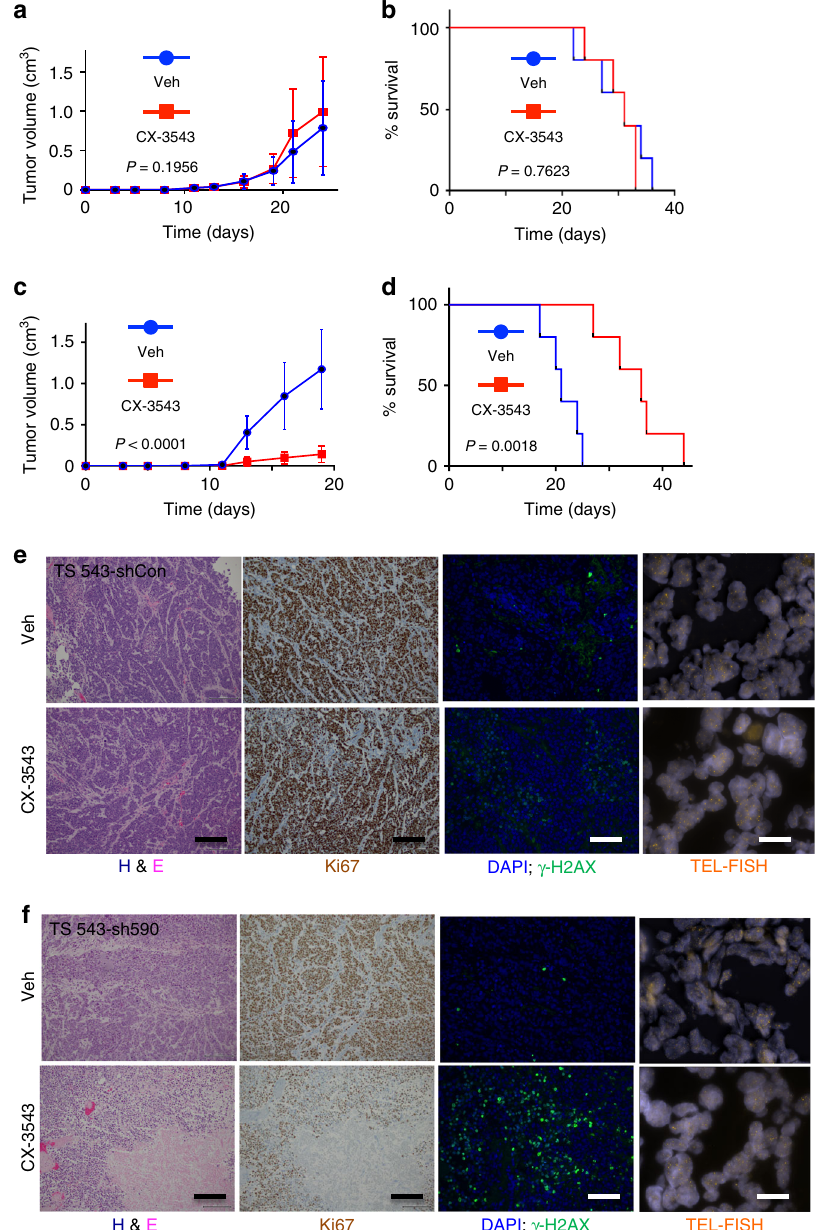
Fig. 8 Ef fi cacy of G4 stabilization in vivo is dependent on ATRX de fi ciency. a TS 543 (ATRX intact) xenografts exhibited similar rates of growth when treated with either vehicle control (Veh, n = 3) or 12.5 mg/kg CX-3543 ( n = 3) as re fl ected by tumor volume over time. b Kaplan – Meier analysis of survival In a separate cohort of 10 mice randomized (5 and 5) into two groups, receiving either 12.5 mg/kg CX-3543 or vehicle control (Veh). c ATRX knockdown in TS 543 cells (sh590) restored the sensitivity of xenografts to CX-3543 treatment as shown by tumor volume over time in 10 mice randomized (5 and 5) into two groups, receiving either 12.5 mg/kg CX-3543 or vehicle control (Veh). d Kaplan – Meier analysis of survival In a separate cohort of 10 mice randomized (5 and 5) into two groups, receiving either 12.5 mg/kg CX-3543 or vehicle control (Veh). e , f Representative H&E-stained, immunostained (Ki67 and γ -H2AX), and TEL-FISH stained sections of xenografts from vehicle (Veh) and CX-3543-treated mice harboring either TS 543-shCon ( e ) or TS 543-sh590 ( f ) xenografts. CX-3543-associated histopathological effects were limited to TS 543-sh590 xenografts. Evidence of ALT was not seen in either GSC line. P values were determined by two-way ANOVA for tumor growth and Log-rank (Mantel – Cox) test for survival curve comparison; scale bars represent 200 μ m in staining panels and 25 μ m in Tel-FISH